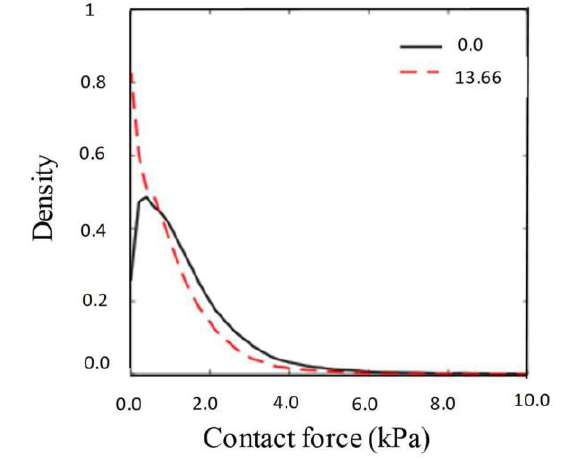
Fig. 8 . Probability density of contact force at a different level of dissolution ( 𝑅 xd = 10 –2 ).